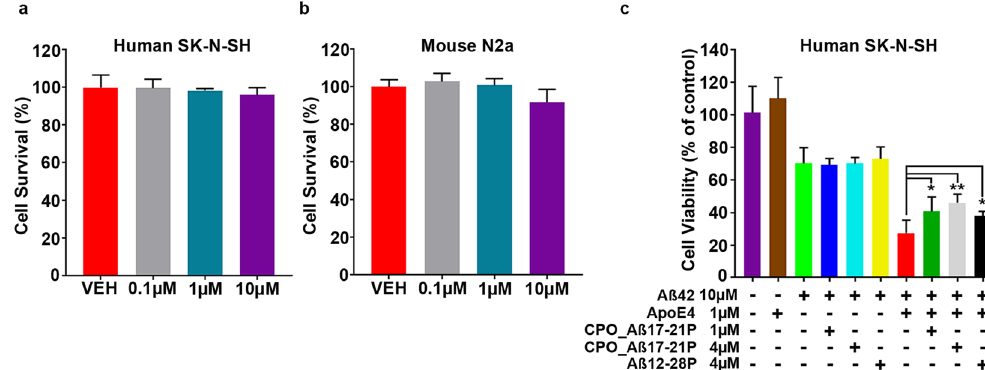
Figure 2. Cytotoxicity of peptoid CPO_ A β 17-21 P on SK-N-SH human neuroblastoma cells and mouse N2a neuroblastoma cells and inhibition of A β 42/apoE4 cytotoxicity by pre-incubation of apoE4 with CPO_A β 17- 21 P. ( a ) CellTiter-Blue ® cytotoxicity assay showing no significant differences between vehicle and CPO_ A β 17- 21 P at 0.1, 1 and 10 µ M. on human SK-N-SH neuroblastoma cells or on ( b ) mouse N2a neuroblastoma cells. ( c ) Toxicity effect of A β 42 on human SK-N-SH neuroblastoma cells and potentiation of toxicity in presence of apoE4. CPO_ A β 17-21 P peptoid reduces significantly the toxicity of A β 42/apoE4 at 1 and 4 µ M ( ** p < 0.01, * p <